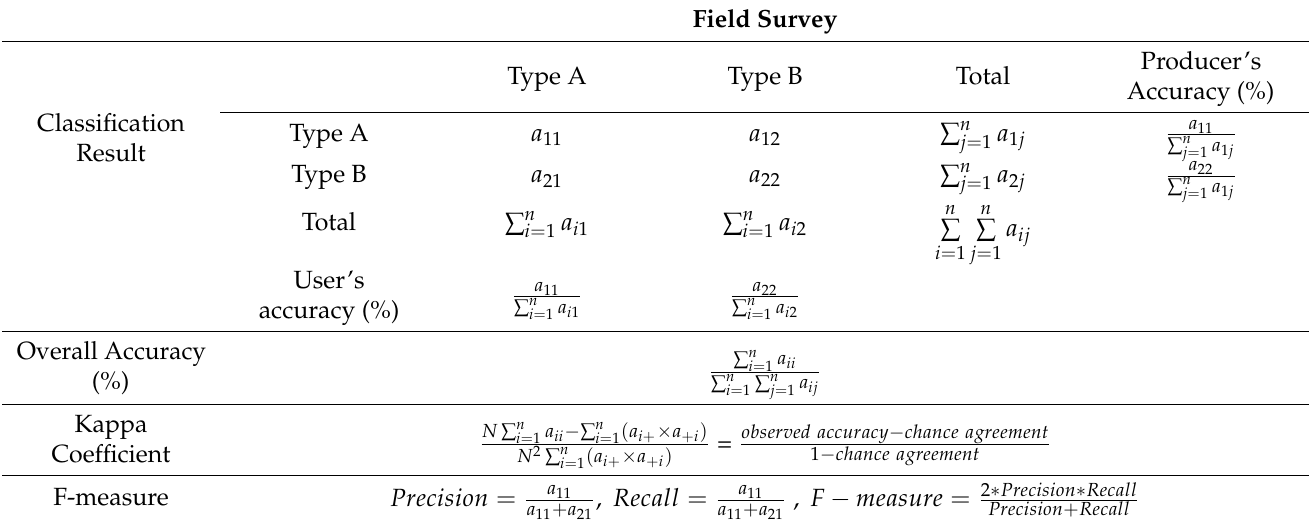
Table 1. Equations related to classification error evaluation by the error